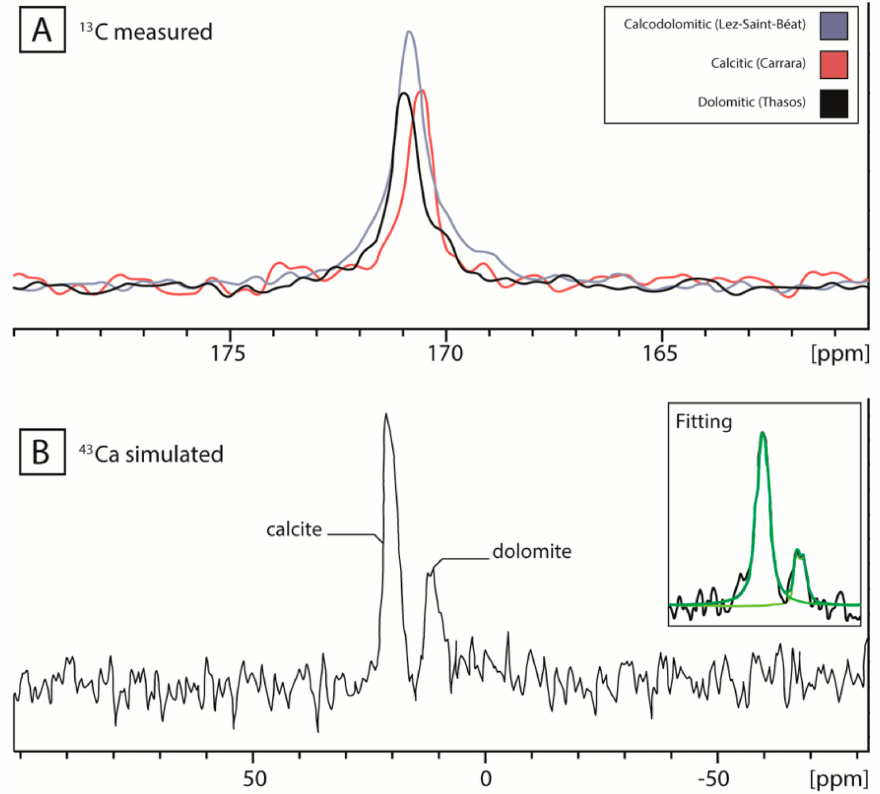
Figure 2. ( A ) 13 C NMR spectra of dolomitic (Thasos, black), calcitic (Carrara, red), and dolomito- calcitic (Lez-Saint-B é at, written Saint-B é at in the figure, blue) marbles. ( B ). 43 Ca NMR spectrum of dolomito-calcitic (Lez-Saint-B é at). Insert represents the best fits (in green) obtained for 43 Ca NMR spectrum simulation using the following physico-chemical parameters: calcite, δ iso 22.7 ppm, C Q , 1.4 MHz, η Q 0.1; dolomite, δ iso 14.0 ppm, C Q , 2.0 MHz, η Q